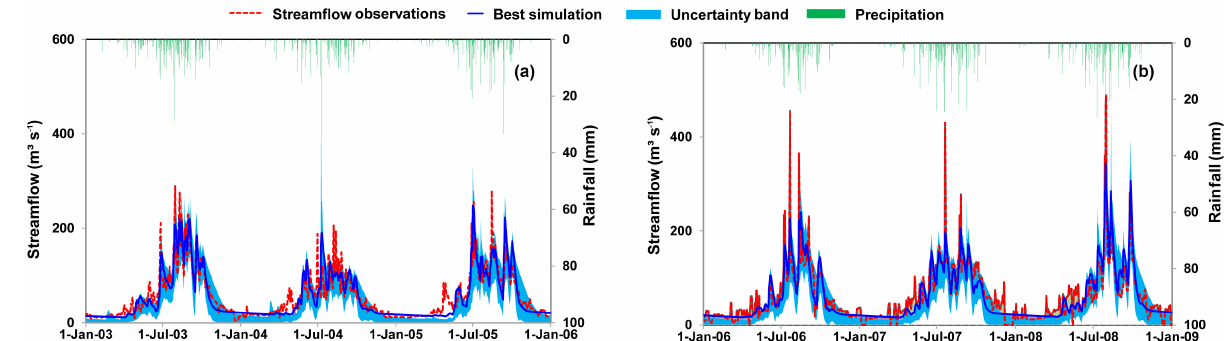
Figure 4. Simulated streamflow for the benchmark calibration of the Heihe Basin in both the calibration (2003–2005) and validation (2006– 2008) periods.